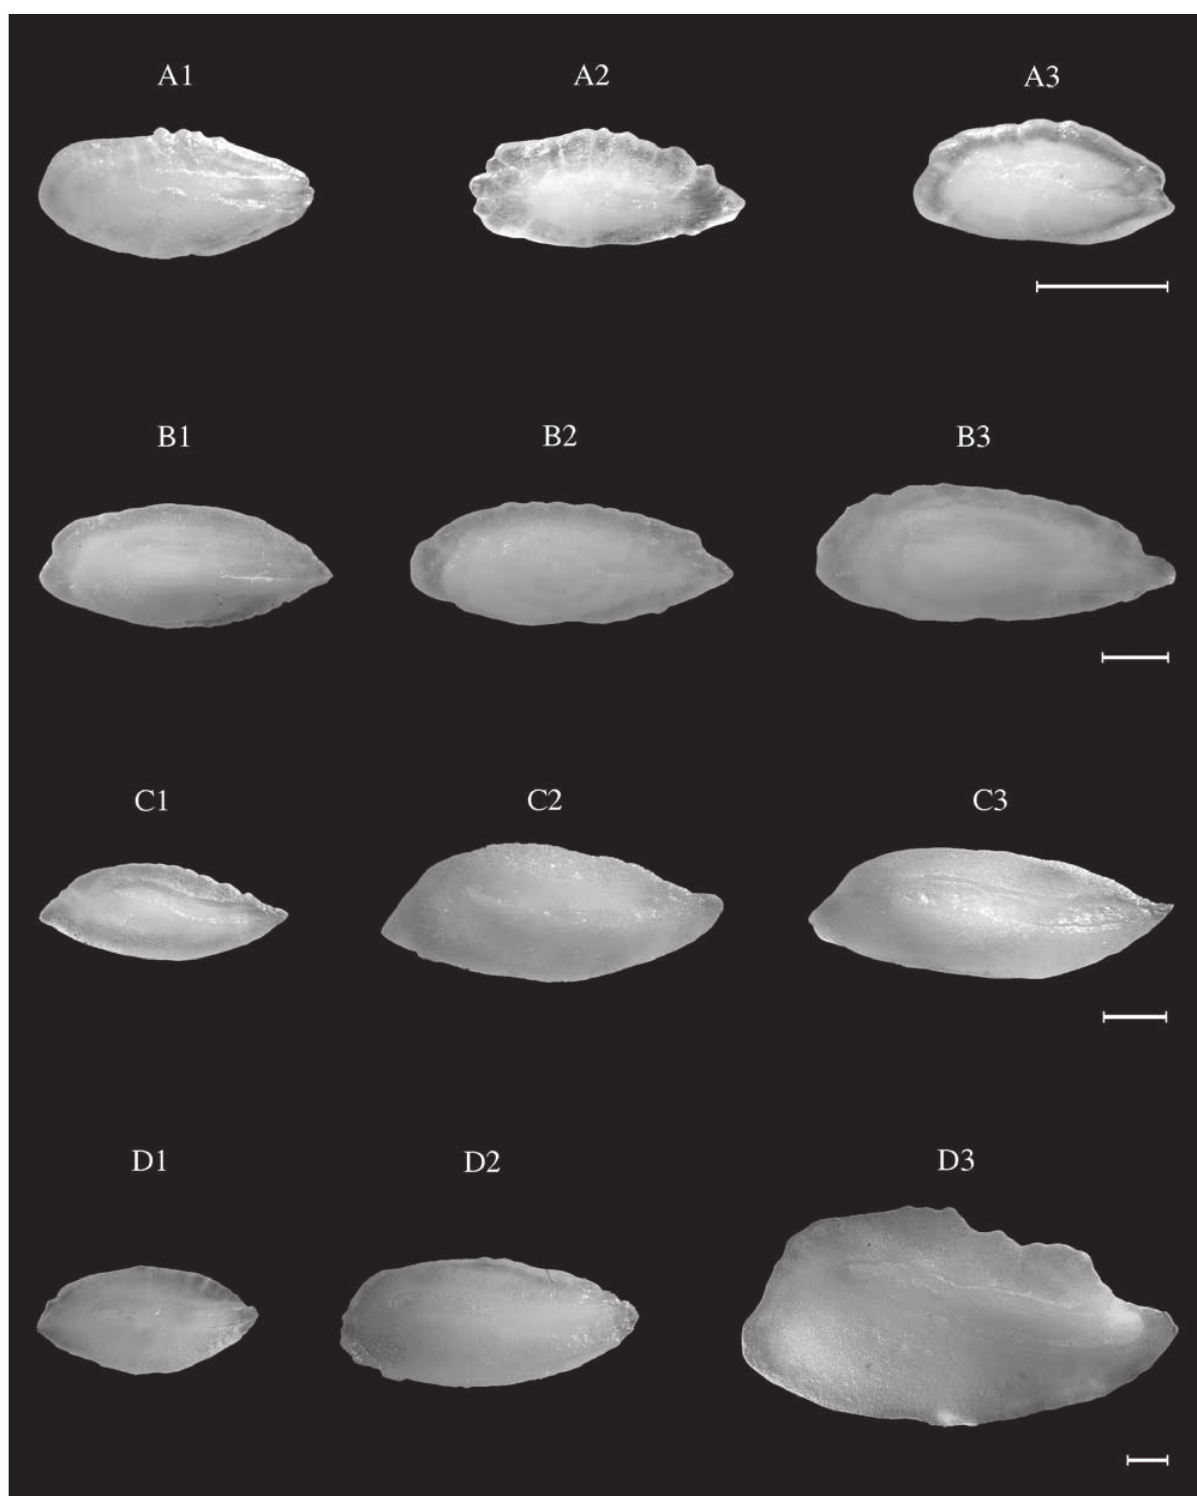
Fig. 74. – Gymnammodytes semisquamatus (WM) . TL: A1, 11.6 cm; A2, 13.0 cm; A3, 14.0 cm. Hyperoplus lanceolatus (NEA) . TL: B1, 24.3 cm; B2, 27.3 cm; B3, 31.8 cm. Echiichthys vipera (NEA). TL: C1, 8.3 cm; C2, 11.4 cm; C3, 13.9 cm. Trachinus draco . TL: D1, 11.0 cm (WM); D2, 20.7 cm (CEA); D3, 35.5 cm (NEA). Scale bar = 1